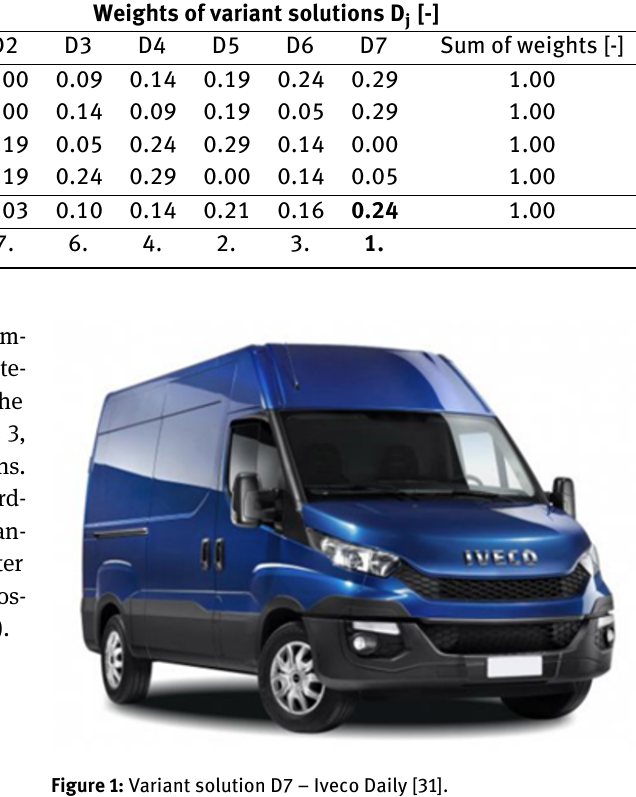
Figure 1: Variant solution D7 – Iveco Daily [31].